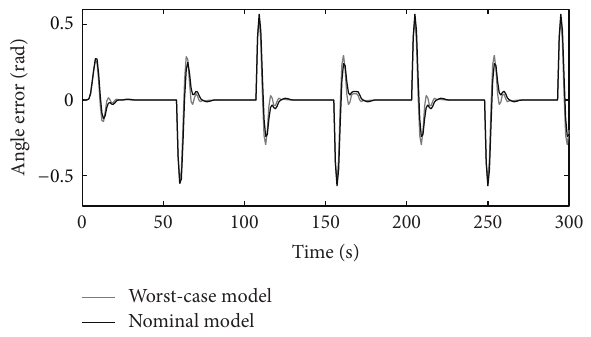
Figure 12: Output of the controller 𝐶(𝑠) .